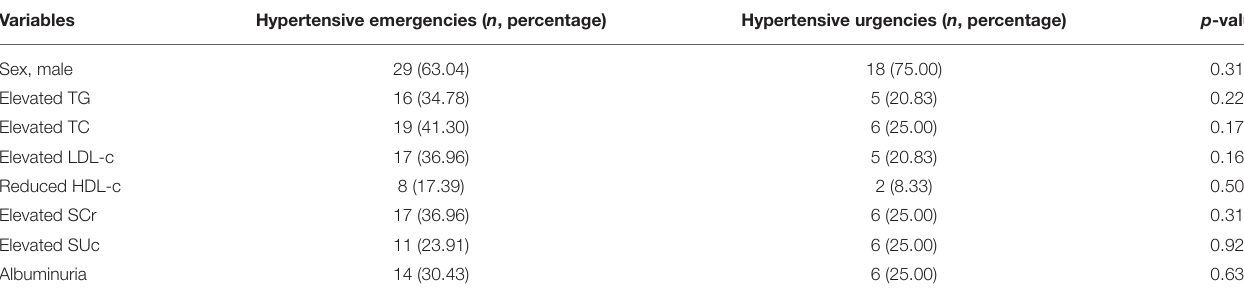
TABLE 3 | Variables of hypertensive emergencies and urgencies.